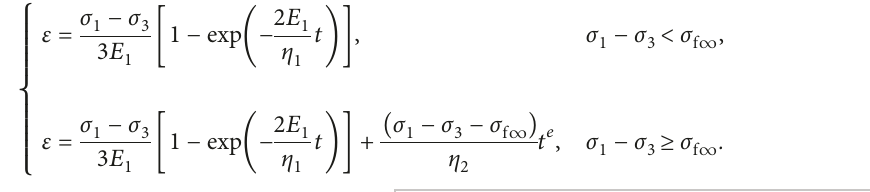
� 10MPa): (a) 3 d, (b) 7 d, (c) 14d, and (d) 1